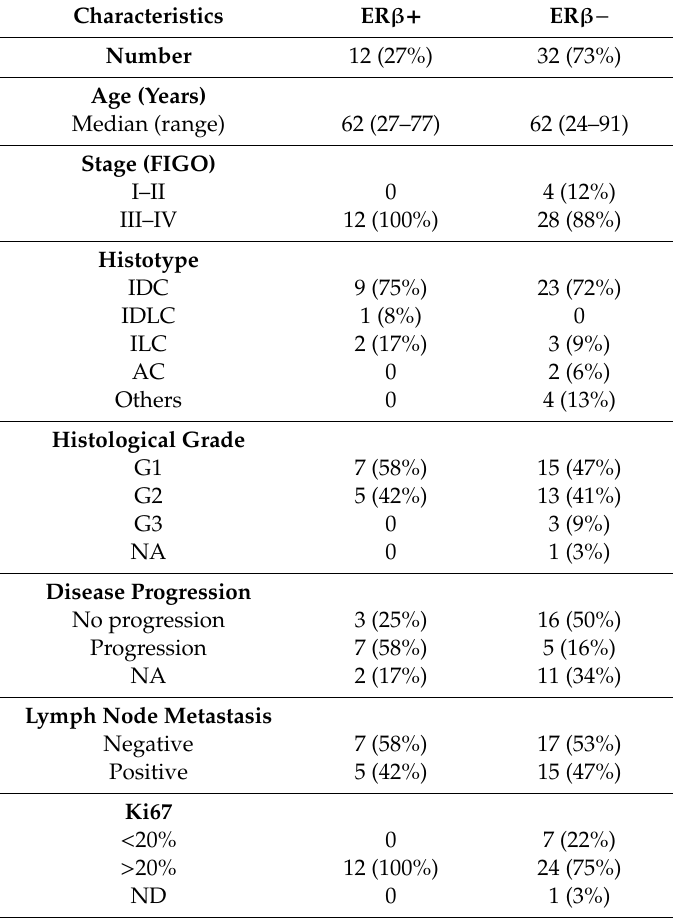
FIGO—International Federation of Gynecology and Obstetrics, IDC—invasive ductal carcinoma, ILC—invasive lobular carcinoma, IDLC—mixed invasive ductal / lobular carcinoma, AC—atypic carcinoma, Others—other carcinoma types, ND—not determined, NA—not